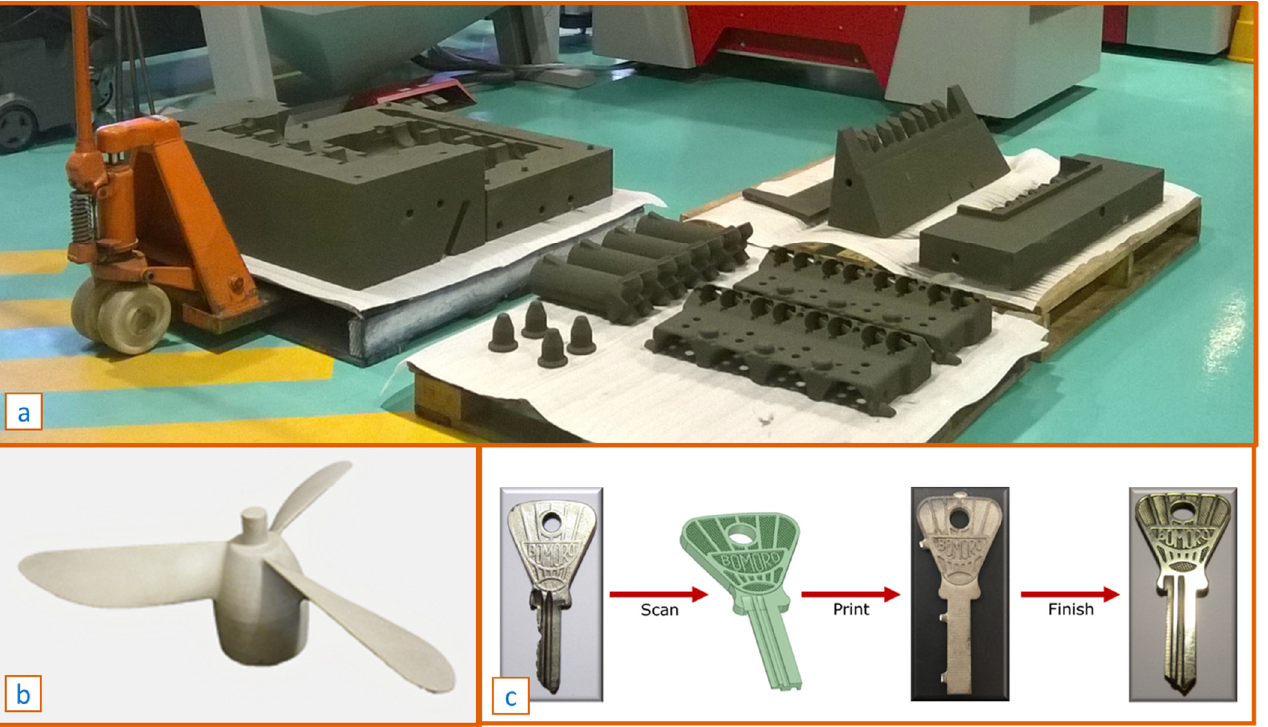
Figure A3. Polymer spare-part reconstruction based on indirect AM processes: ( a ) Sand moulds for casting the engine block of the 1914 Delage Type-S (photo credits: Voxeljet). ( b ) Investment-cast fan. ( c ) Investment-cast key for door and trunk (photo credits for ( b , c ): Rare Parts Club, a division of Freshmade 3D).